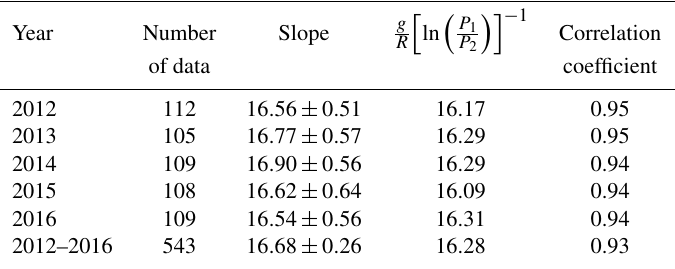
Figure 2. Scatter plots of the daily FWHM of the meteor height distribution versus the average value of the SABER temperatures near the mesopause region at King Sejong Station in (a) 2013 and (b) the 5 years from 2012 to 2016. The blue solid line depicts the linear regression. The histograms of the two independent temperature measurements from the SABER (blue) and MLS (red) and FWHM data are also presented to show the number of data used in the linear least squares. Table 1. Slope values and correlation coefficients exhibiting a linear relationship between the SABER temperature and the FWHM from the meteor radar at KSS from 2012 to